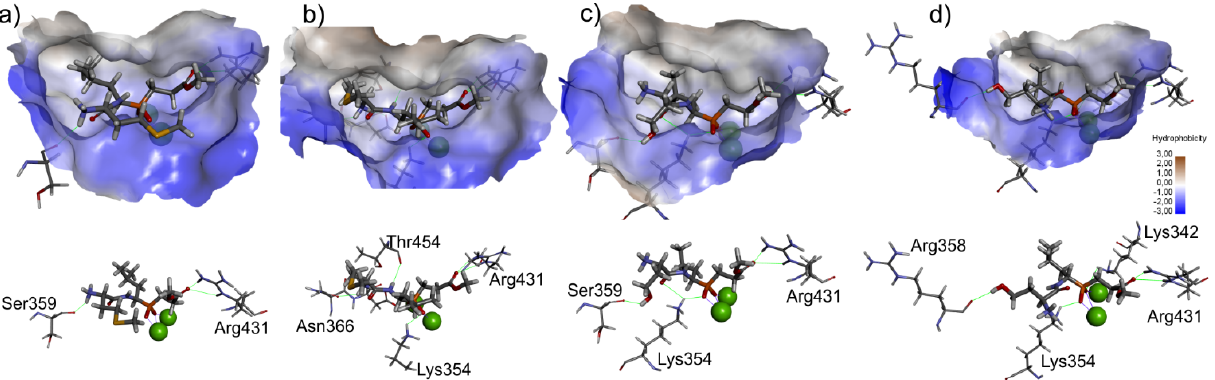
Figure 6. Alignment of ( a ) 2 - SR isomer, ( b ) 2 - SS isomer, ( c ) 3 - SR isomer, ( d ) 3 - SS isomer in the active site of SlAP (PDB: 4KSI). Magnesium ions are shown as a green sphere. Green lines represent intermolecular hydrogen bonds; blue lines represent ligand–metal interactions. The surface of the active site is colored according to hydrophobicity.